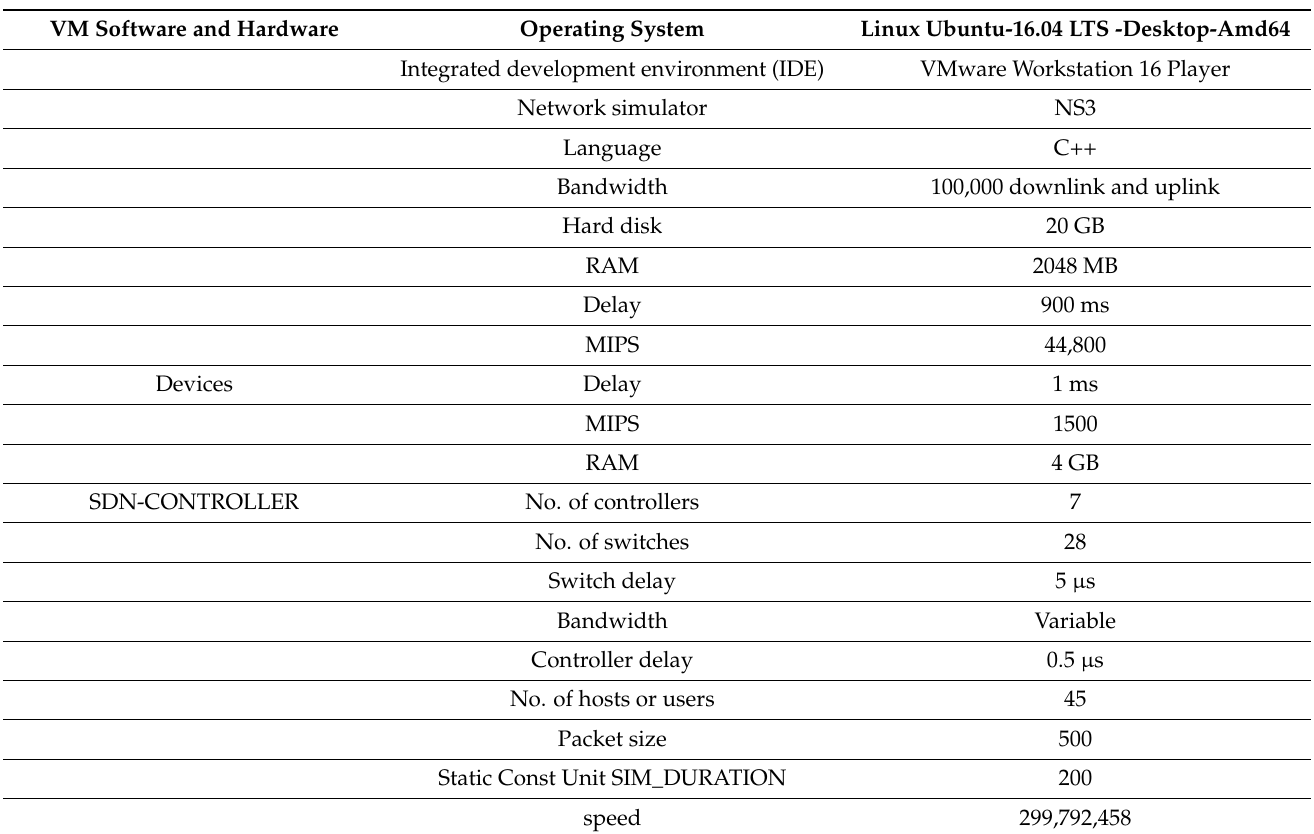
Table 6. Parameter configurations of a virtual machine and an SDN